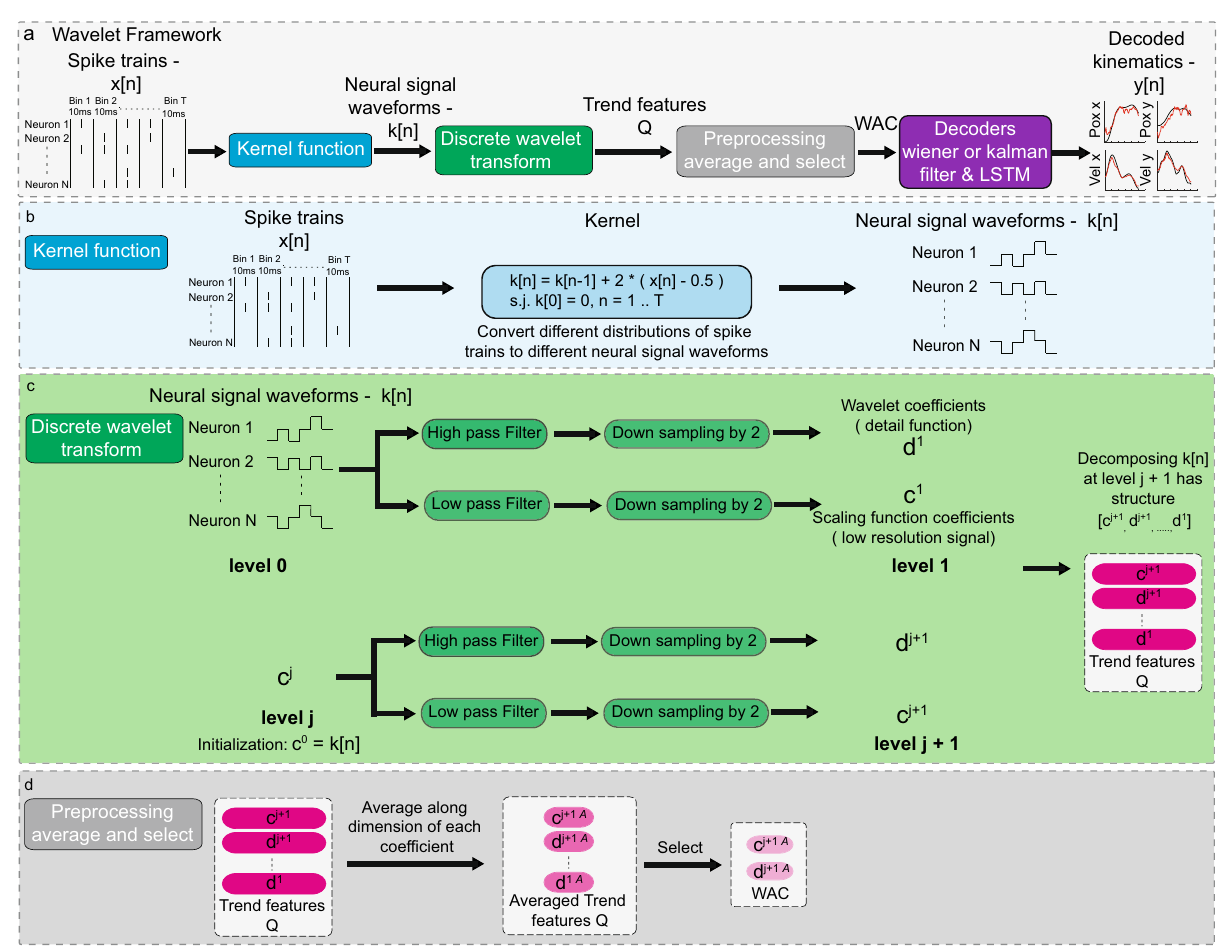
Figure 2. ( a ) Overview of wavelet framework. Given the neural spikes, our model uses kernel functions to transform it into a discrete neural signal waveform that fluctuates with the distribution of spike events. Our model uses discrete wavelet transform to encode this discrete neural signal waveform into trend feature tensor Q to capture the temporal pattern of neural spikes. By preprocessing the trend feature and using it as input to the classical decoder like Wiener and Kalman filters or new LSTM decoder with sliding window approach, we can produce the decoded kinematics with high temporal resolution and high decoding accuracy. ( b ) Kernel function module converts spike trains to a discrete neural signal waveform that would fluctuate with the distribution of the spike events. ( c ) Discrete wavelet transform module captures the temporal patterns of a signal ( d ) Preprocessing module reduces the dimensions by averaging each trend features Q and select suitable trend features as where T is the time horizon. This kernel function outputs a discrete neural signal waveform that would fluctuate with the distribution of spike events (see Discussion for more details). Discrete Wavelet Transform. Wavelet transform 28 is an excellent tool to capture the temporal patterns of a signal. Fourier transform decomposes a signal into different frequency components using different periodic exponential functions. Similarly, wavelet transform decomposes a signal into different wavelet coefficients and a scaling function coefficient using different detail functions that have different scales (see Supplementary Fig. S1). The scaling function coefficient encodes information from the large scale (trend) of the signal. The wavelet coef- ficients encode information from the small scale (details) of the signal. In contrast to Fourier transform, discrete wavelet transform localizes “spike trends” in both time and frequency at different scales. Here, Discrete Wavelet Transform Module (Fig. 2c) encodes different discrete neural signal waveforms with different shapes into dif- ferent trend features Q (concatenation of scaling function coefficient and wavelet coefficients). Trend features Q allow us to use a few parameters to represent the discrete neural signal waveform. We use db3 wavelets 29 as basis to decompose the neural signal waveforms (corresponding to the high and low pass filters in Fig. 2c). This step essentially allows us to describe a complicated waveform such as in Fig. 3A with a few numbers. Preprocessing Module for Generating WAC . Preprocessing Module (Fig. 2d) selects the suitable trend features and further reduces the dimensions of trend features Q by averaging each of them to produce WAC.